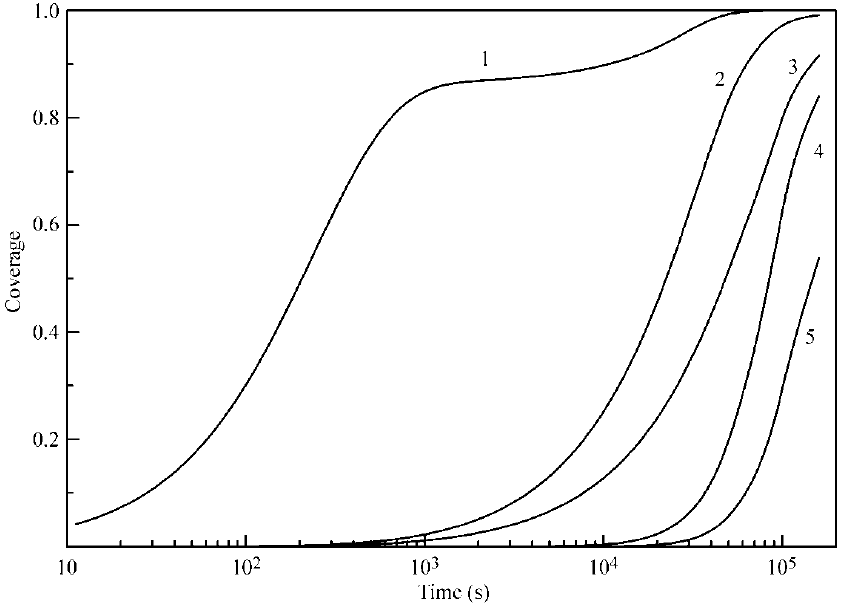
Figure 4. Time dependence of the coverage for each of the five adsorbed layers at 20 °C.